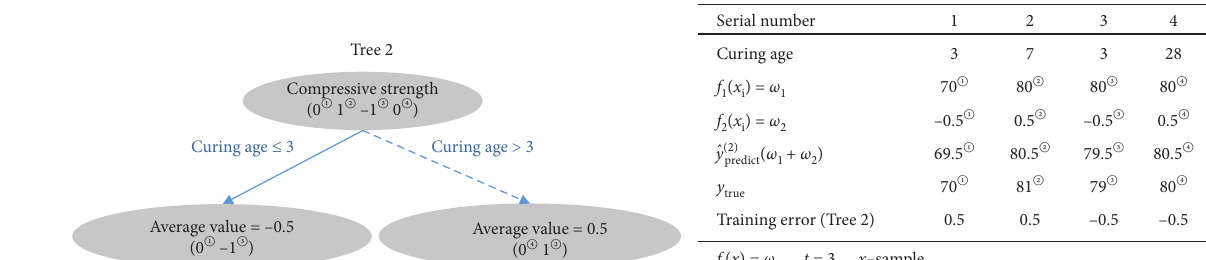
Figure 8: The training process of an XGBoost model (Tree 2).